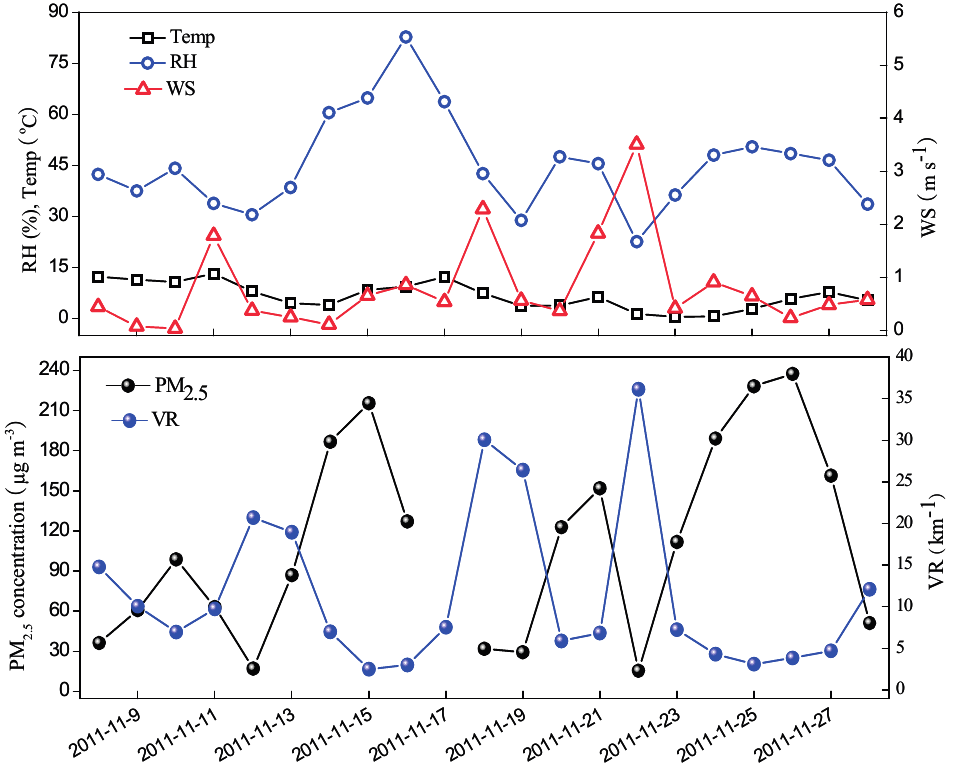
Figure 1. Daily variations of PM 2.5 mass concentration and meteorological